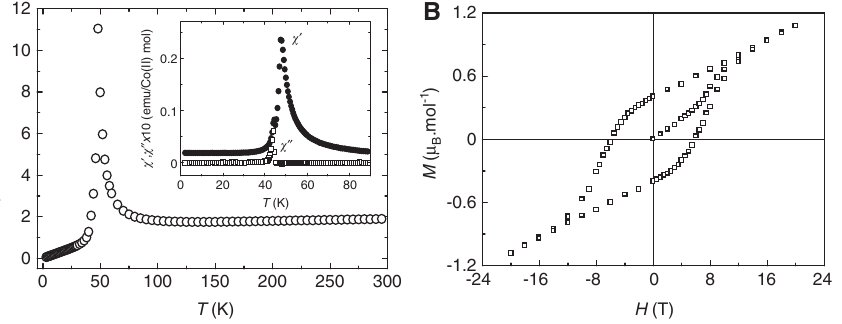
(OH) (C H O ) and (B) hysteresis cycle of magnetization at 4.2 K. Adapted with permission from 2 2 8 4 4